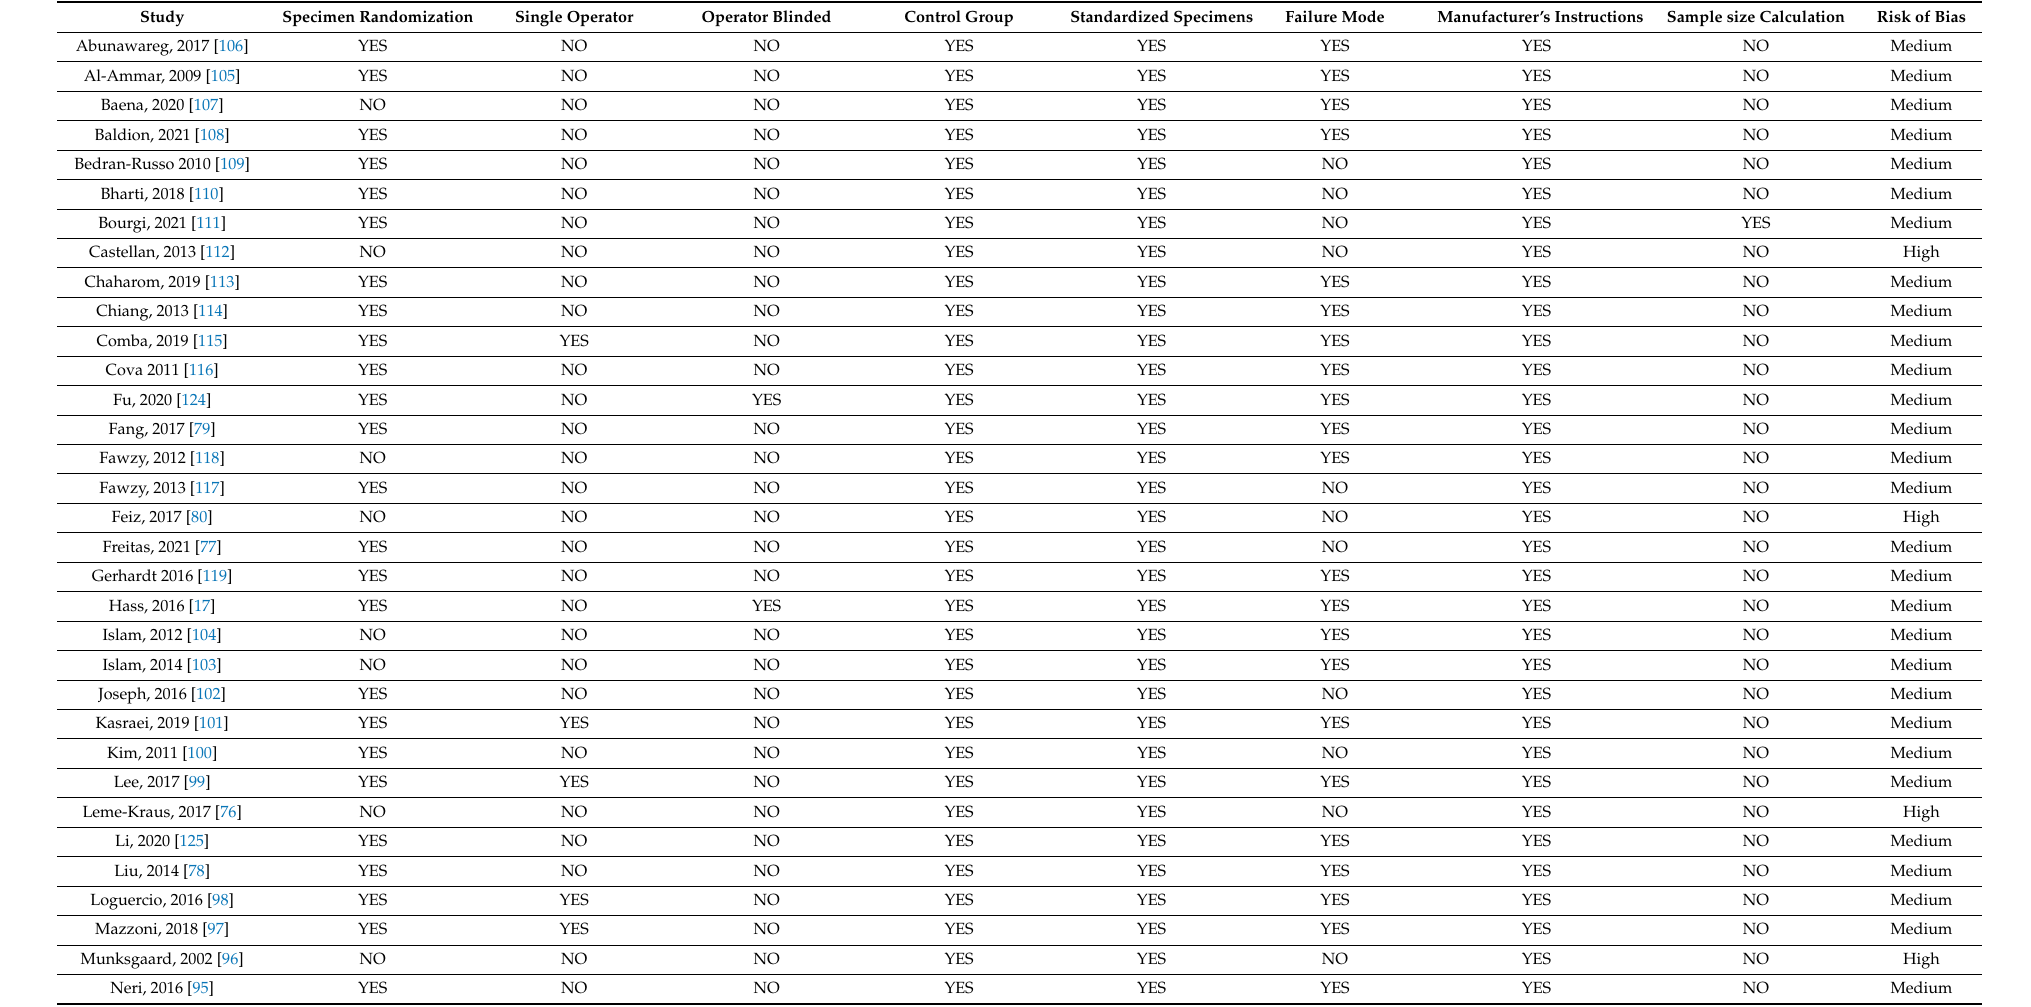
Table 4. Risk of bias of the included